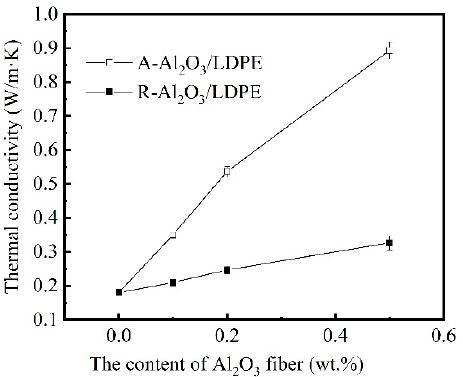
Figure 8. The thermal conductivity of the nanocomposites containing various amounts of Al 2 O 3 fi- ber.